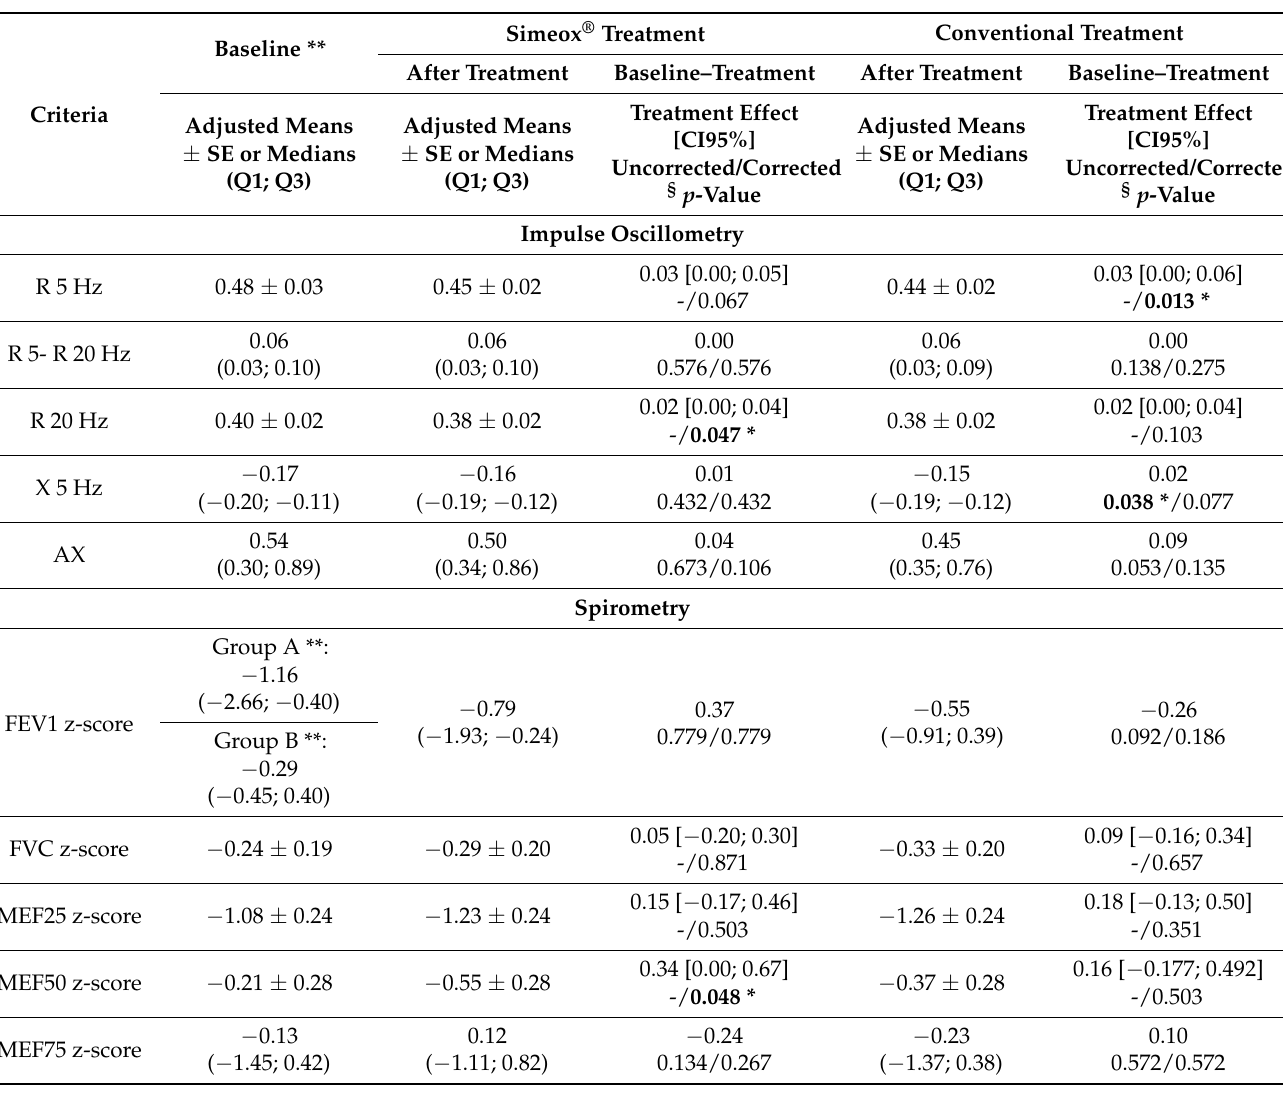
Table 5. Comparisons of pulmonary functions tests (treatments against